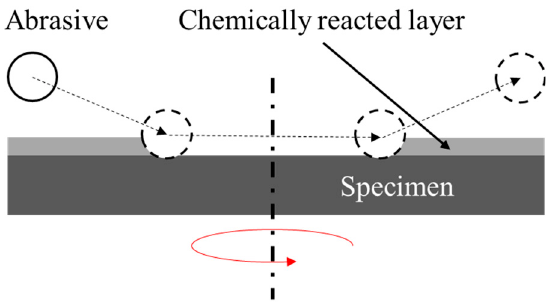
Figure 2. Material removal mechanism of FB-CMP.